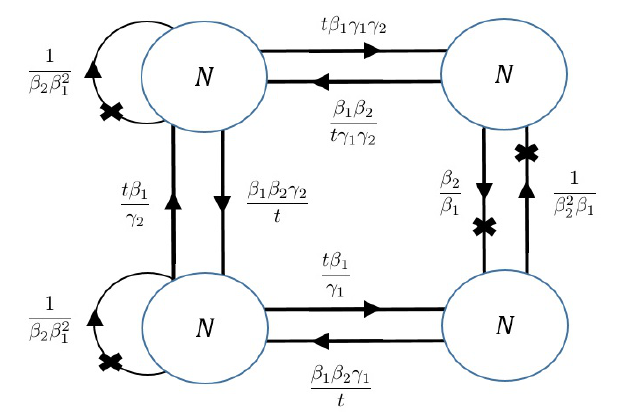
Figure 7 . The quiver diagram for the 4d class S 3 theory corresponding to a torus with two units of (cid:12) 1 (cid:13)ux and one of (cid:12) 2 (cid:13)ux. Next to the (cid:12)elds are their charged summarized using fugacities. This theory has a combination of cubic and quartic superpotential terms. Again these are most conveniently generated by taking all terms consistent with the symmetries. Additionally there are superpotential terms coming from the (cid:13)ipping. The theory also has an R -symmetry, a convenient choice for which is to give all the bifundamentals R -charge 1 , and R-charge 1 for the adjoints and 2 their